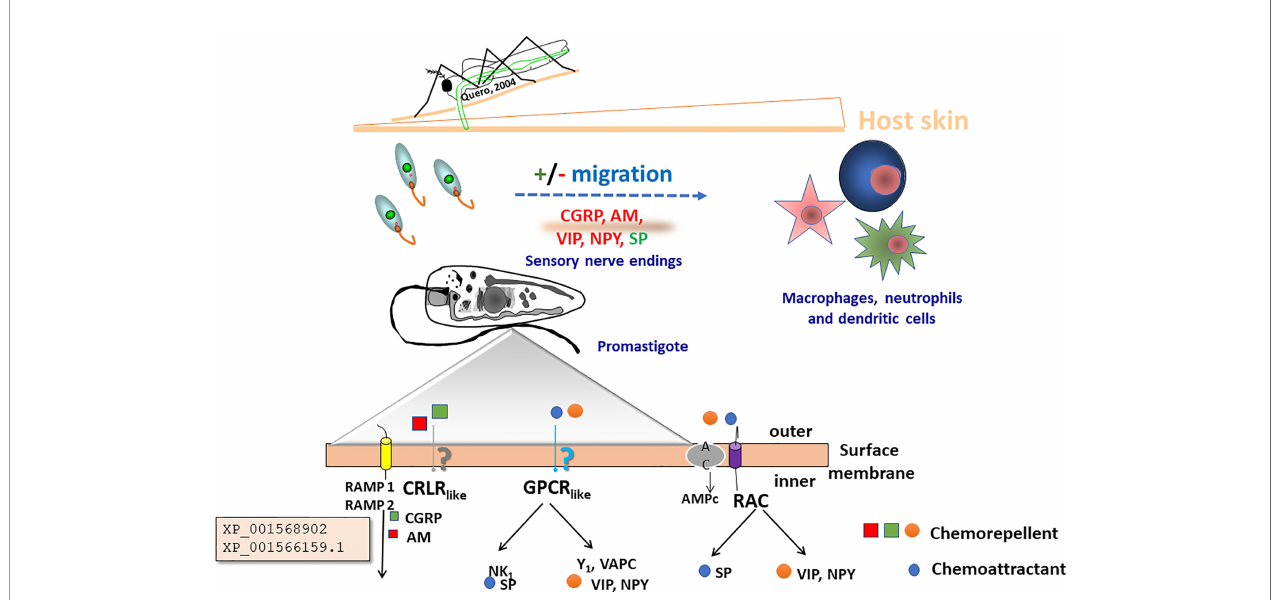
FIGURE 5 | Proposed mechanism by which the novel Leishmania proteins, XP_001568902 and XP_001566159.1, may play a role in the completion of the lifecycle of the parasite. After fi rst inoculation of the promastigote into the skin, the parasite in its promastigote form reacts against neuropeptides secreted by the nerve terminals in the skin. Adrenomedullin (AM) secreted by the epithelial cells, and calcitonin gene-related peptide (CGRP) induce a negative chemotactic response in the parasite. Potentially they may induce metabolic activation before the invasion of the macrophages and the dendritic cells (DC). The zoom detail depicts fl agellum membrane organization including a scheme of potential transmembrane receptors that may be (NK1, Y1 and VAPC), G-protein (like), CRLR (like) coupled RAMP (1,2) receptors (Giammarressi et al., 2020), and RAC